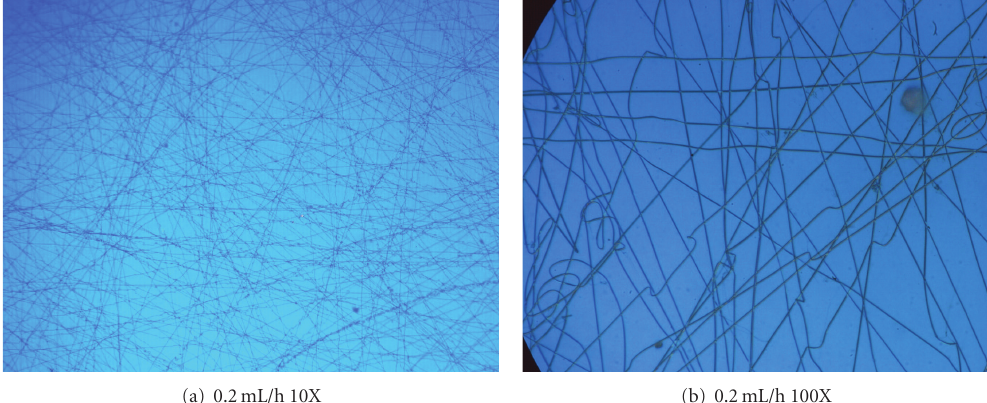
Figure 3: Optical microscope micrographs of electrospun nylon fibers.